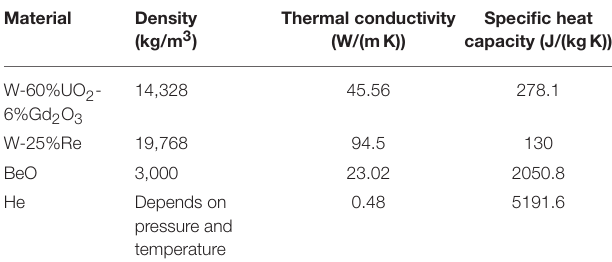
TABLE 4 | Physical properties of reactor core materials and coolant.